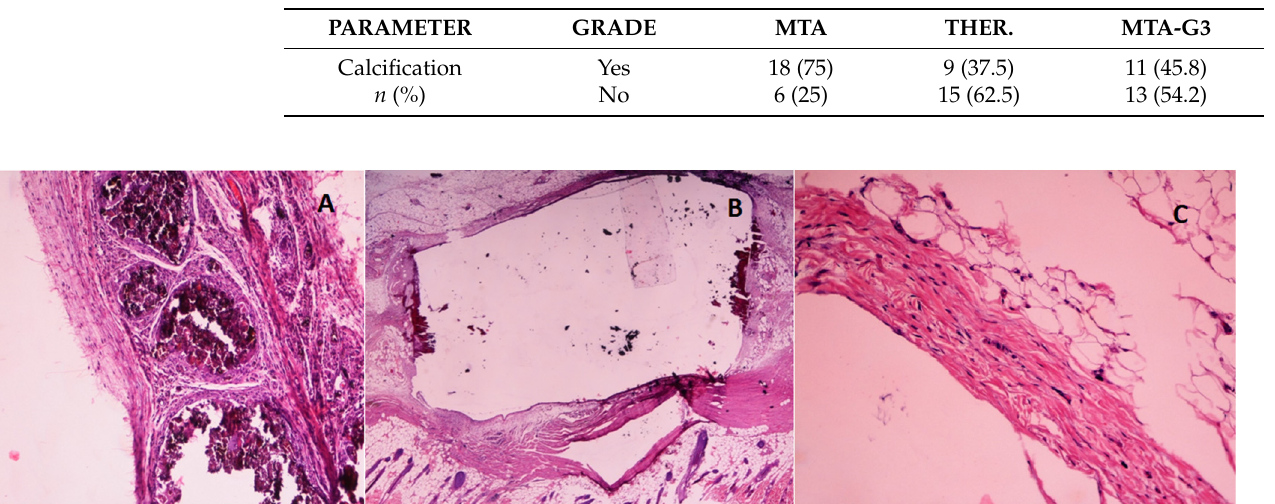
Table 7. Presence of MTA, Theracal and MTA-G3 calcifications.